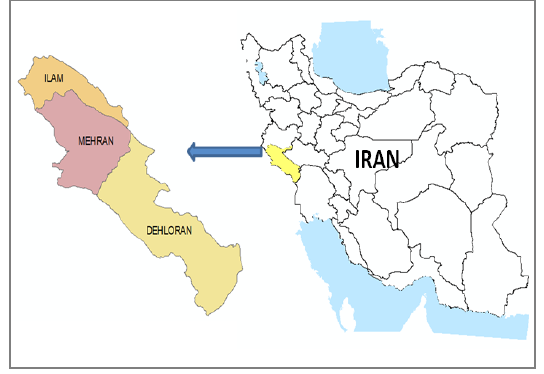
Figure 1.Ilam province and its counties in southwest Iran.